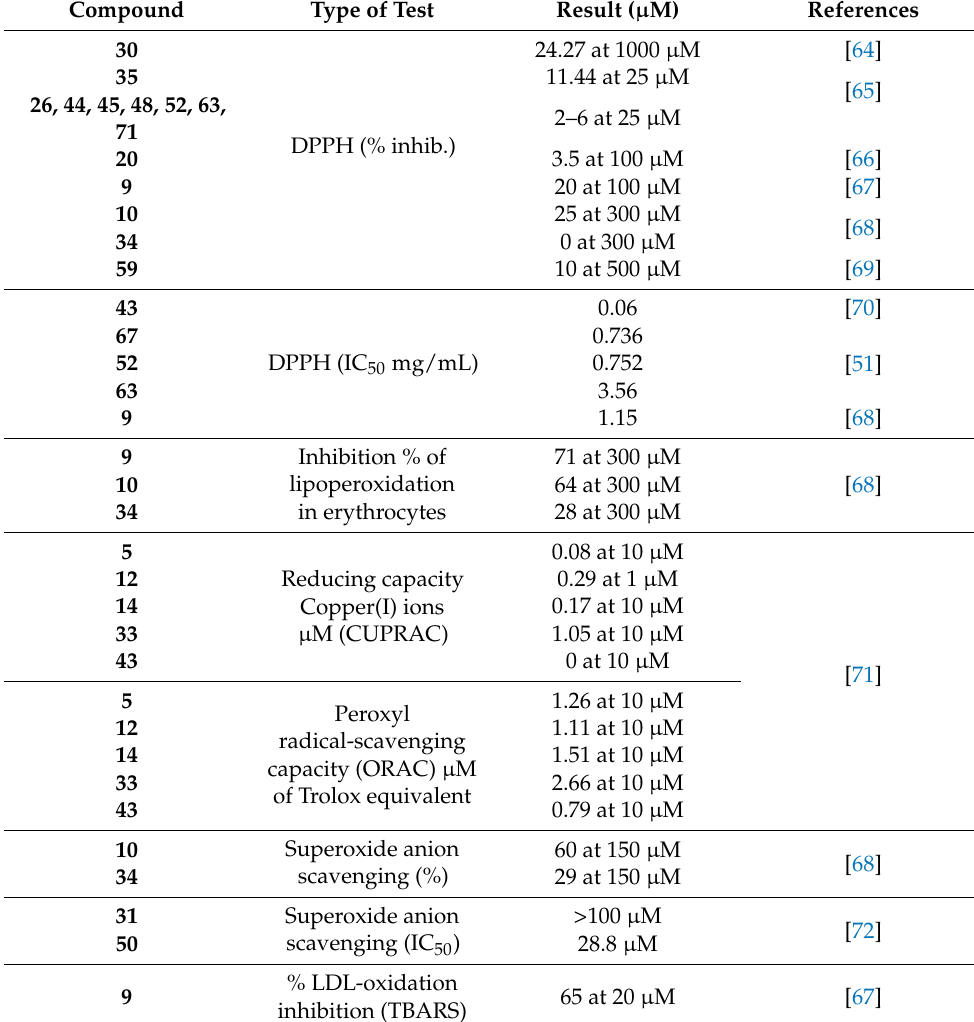
Table 4. Radical scavenging activity of PMFs and HPMFs from Citrus genus. Compound Type of Test Result ( µ